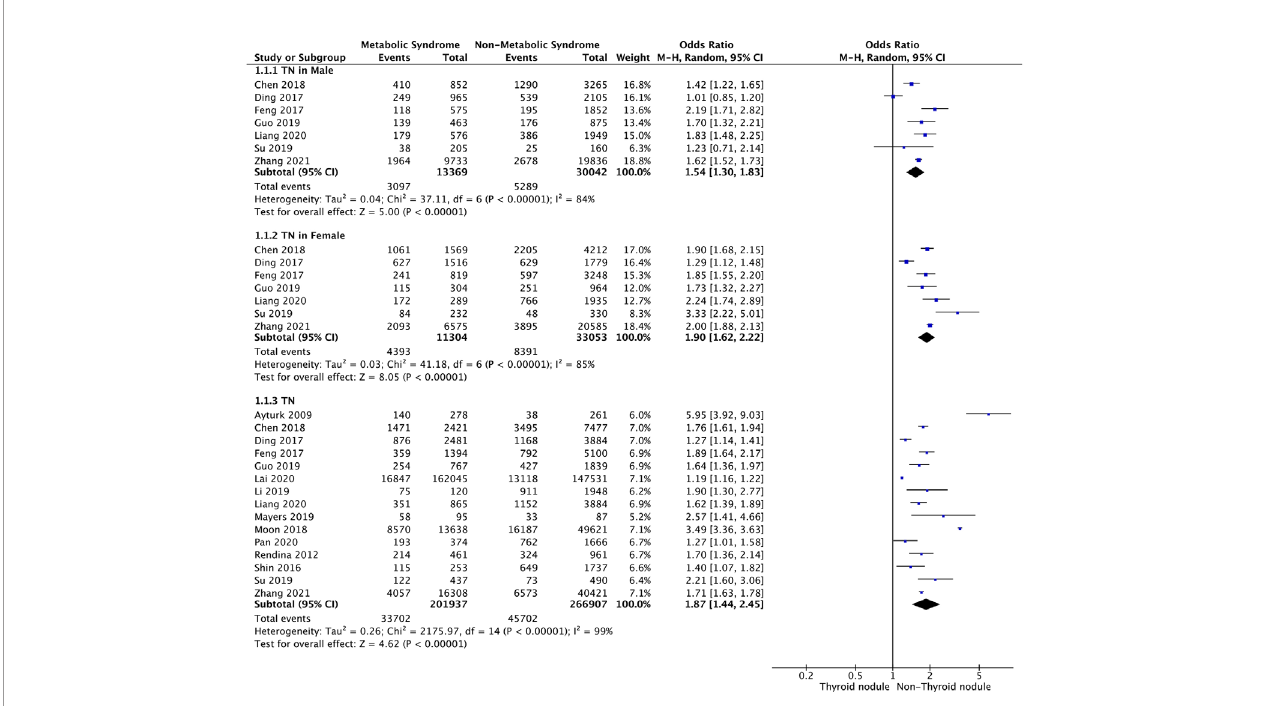
FIGURE 2 | Forest plots of the association between MetS and